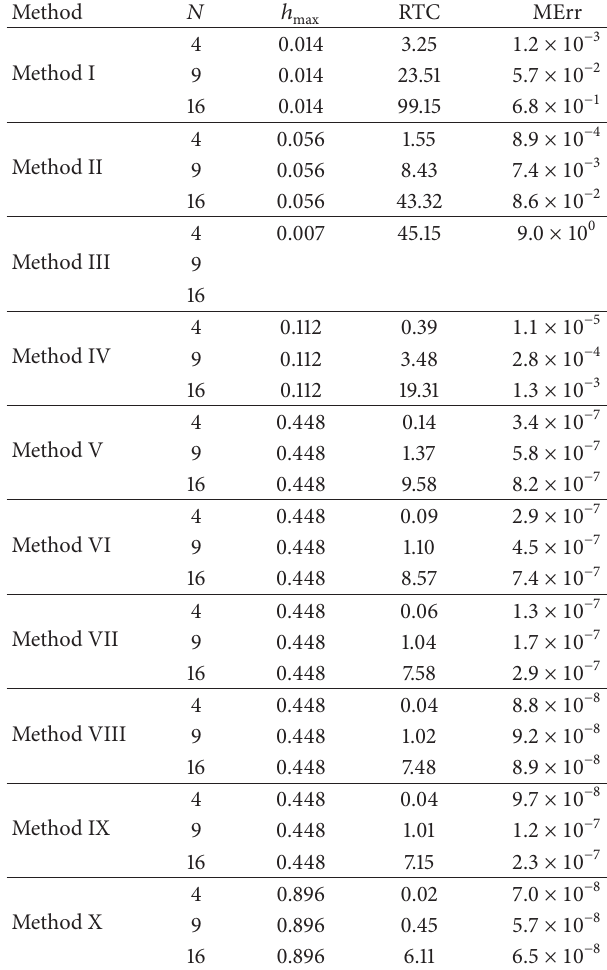
Table 1: Coupled differential equations. Real time of computation (inseconds)(RTC)andmaximumabsoluteerror(MErr)tocalculate |𝑆| 2 for the variable step methods, Method I–Method X. acc = 10 −6 . We note that ℎ max is the maximum step size. 𝑁 indicates the number of equations of the set of coupled differential